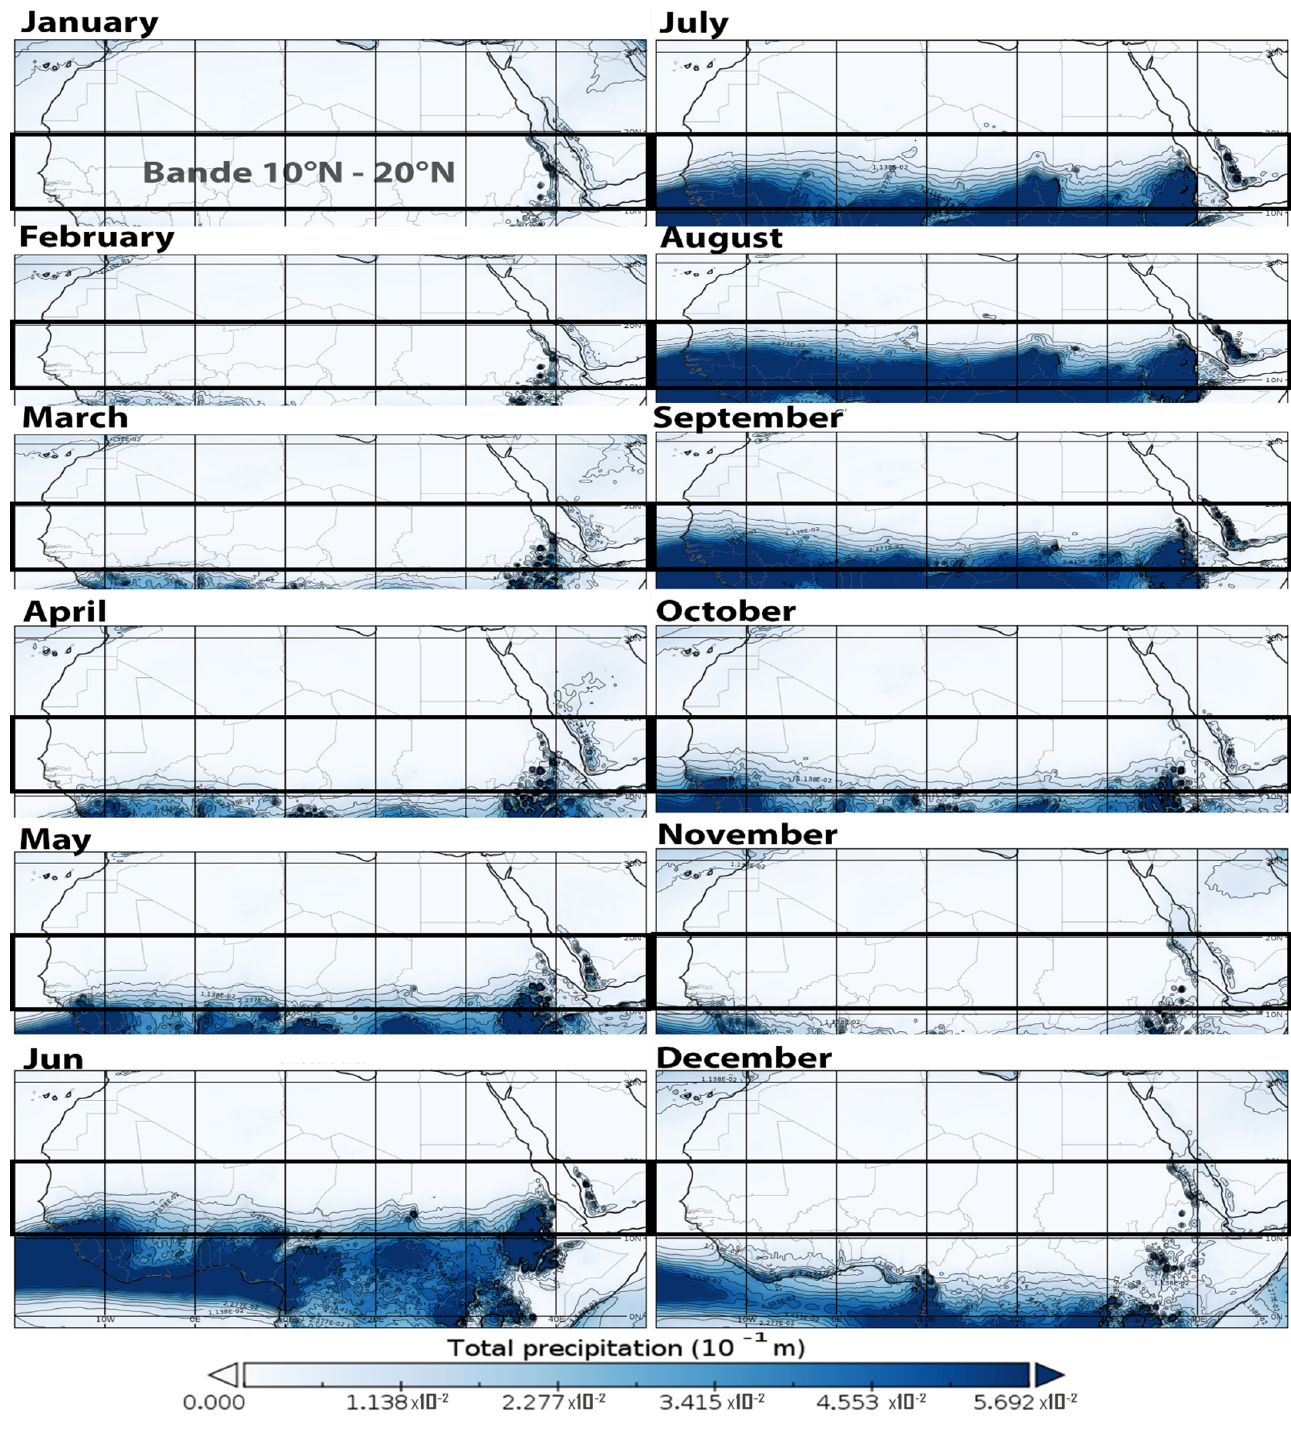
Figure 3. Climatology in monthly average of total precipitation from 1979 to 2008 (4D-Var ERA5) with a resolution of 0.5 × 0.5 degrees. Data from the ERA5 platform.